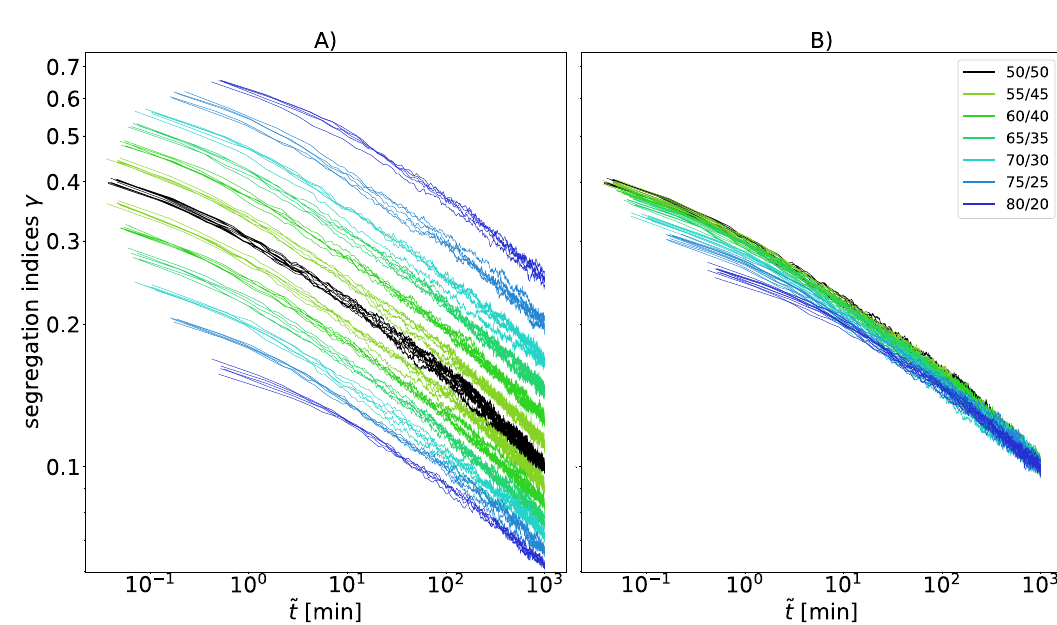
Fig 9. Segregation indices obtained from the simulation shown for a range of cell type ratios. For each simulation we use 100 2 cells, periodic boundary conditions, db = 0, β � = 3, and a random mixture as initial configuration. For comparability, the time scale of migration τ of each simulation is set such that all simulations reach segregation indices γ 0 and γ 1 with γ 0 N 0 = γ 1 N 1 = 500 at dimensionless time ~ t ¼ 1 . Every color represents a specific cell type ratio, while each cell type ratio was simulated five times. Panel A shows the raw data of the simulations. The black lines correspond to an even cell type ratio, for which both segregation indices match, while for uneven ratios the segregation index of the more abundant cell type is below the black line and the other above. Panel B shows the same data where each segregation index γ i is rescaled to a segregation index ~ g ~ g ¼ 2 g = ð N þ N Þ 0 0 N 0 1 0